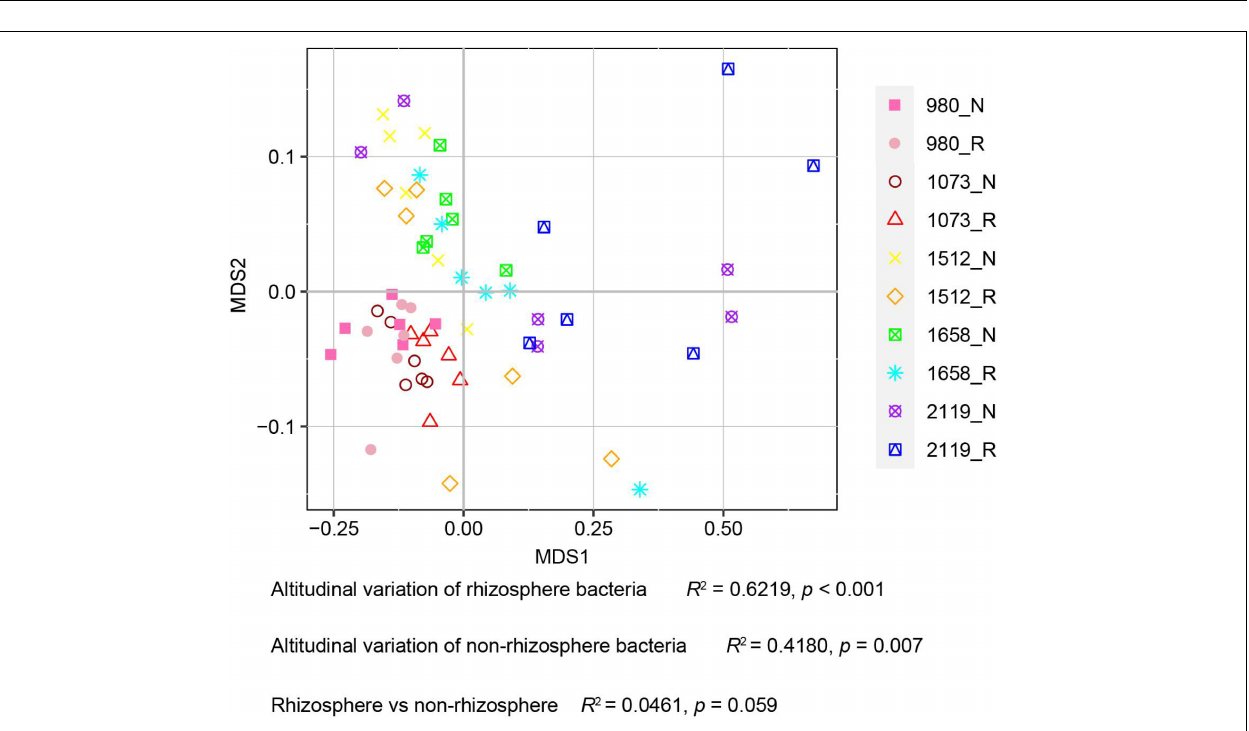
FIGURE 2 | Violin plot showing general patterns of bacterial alpha-diversity along the elevational gradient. The violin frame shows the kernel density of the data distribution. Box-whisker plot inside the violin plot represents the degree of dispersion. abc Different superscripts indicate the significant difference between the pairwise comparison ( p < 0.05). R and N indicate rhizosphere and bulk soil samples, respectively.